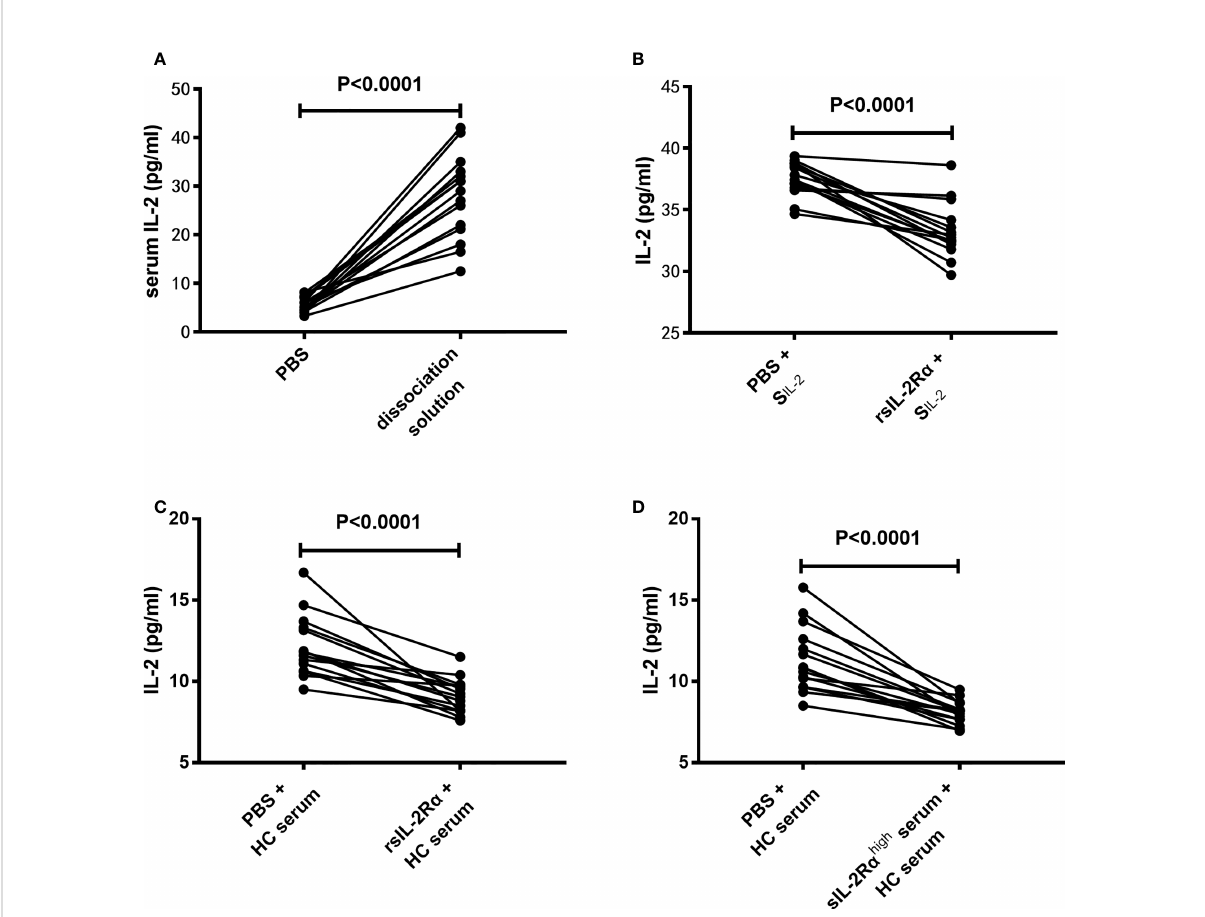
FIGURE 4 Effects of sIL-2R a on the detection level of IL-2. (A) The serums of SLE patients were pretreated with immune complex dissociation solution or equal volume of PBS at 37°C for 30 min and detected for IL-2 levels by ELISA. (B) IL-2 standards were co-incubated with recombinant sIL-2R a or equal volume of PBS for 1 h and detected for IL-2 levels by ELISA. (C) Serums of healthy controls were co-incubated with recombinant sIL- 2R a or equal volume of PBS for 1 h and detected for IL-2 levels by ELISA. (D) Serums of healthy controls was mixed with serums from new onset SLE patients with high levels of sIL-2R a or equal volume of PBS for 1 h and detected for IL-2 levels by ELISA. S IL-2 standard of IL-2; rsIL- 2R a recombinant sIL-2R a